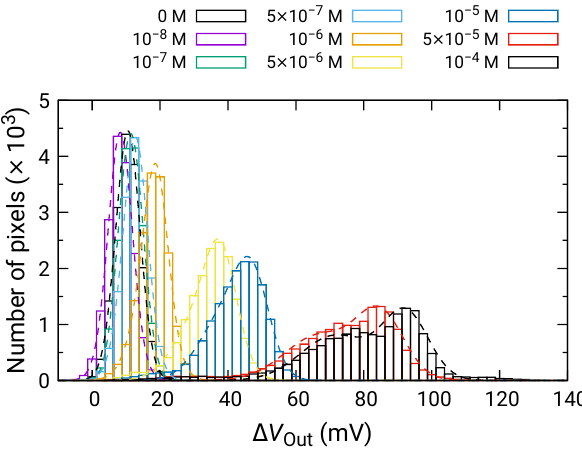
Figure 7. Time-dependent output change for various H 2 O 2 concentrations, where control indicates addition of RM without H 2 O 2 . Sample solutions containing H 2 O 2 were added at approximately 60 s as indicated by an arrow.